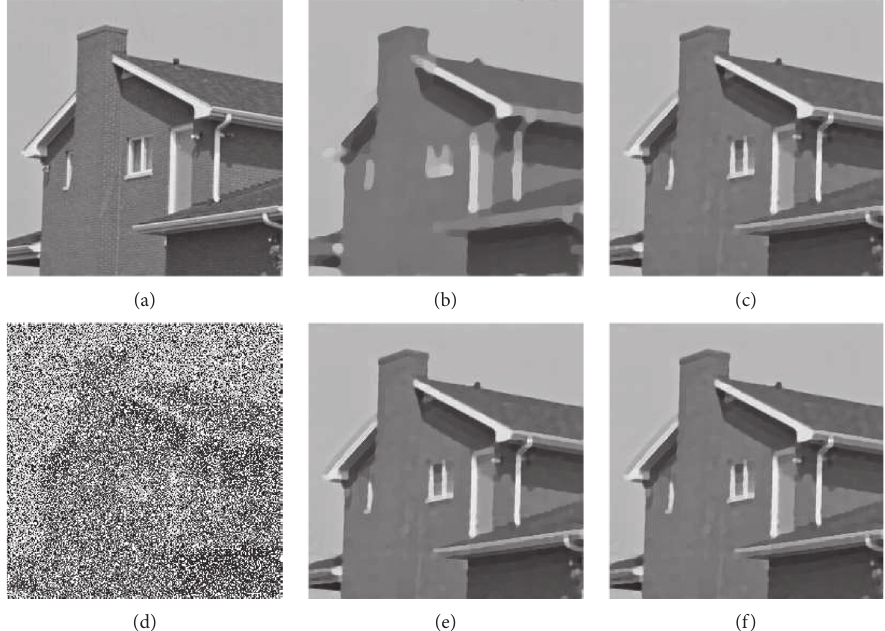
Figure 2: The recovery results (House 256) by Gaussian blur with 60% SP noise. (a) Original. (b) TVL1, PSNR � 24.6266. (c) TVSCAD, PSNR � 30.3598. (d) Gaussian blur (lev � 0.6). (e) TVLog, PSNR � 30.3535. (f) LogTVSCAD, PSNR � 30.3635.